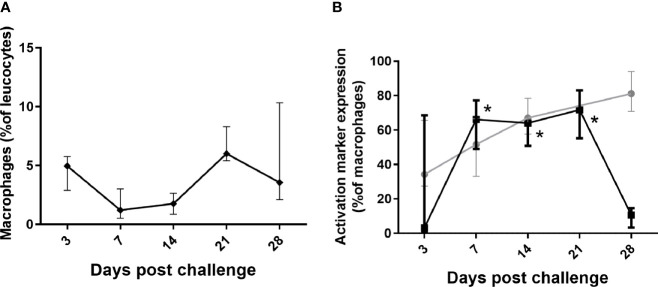
Changes in lung macrophages in marmosets following inhalational challenge with C. burnetii. (A) macrophages as a proportion of leucocytes and (B) change in expression markers, CD16 (gray circle) and CD40 (black square) on macrophages. Data is median and interquartile range, significance from Day 3 by ANOVA; indicated by asterisks; *p<0.05.